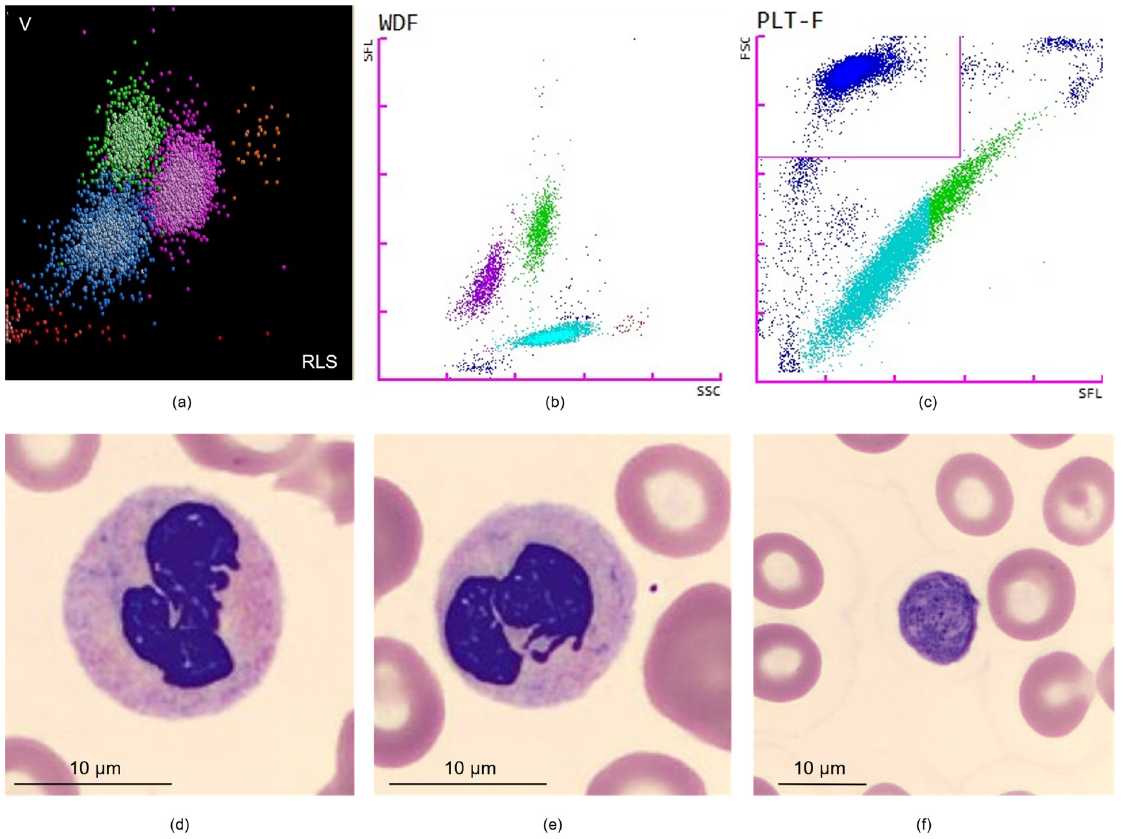
Figure 4. Illustration of typical MDS cases on DxH 800 and Sysmex-XN. ( a ) Leukocyte differential plot from DxH 800, showing decreased light scattering in a patient with myelodysplastic syndrome with excess blasts (MDS-EB-1). LMALS-NE-M, UMALS-NE-M and MALS-NE-M were decreased (128, 127 and 131, respectively). ( b ) Leukocyte differential plot from Sysmex-XN showing an increased Ne-WX (427) in this patient with normal neutrophil count (3.1 × 10 9 /L). This patient had normocytic anemia (Hb 9.7 g/dL, MCV 90 fL) and thrombocytopenia (platelet count: 107 × 10 9 /L), the MDS-CBC score was highly suggestive of MDS (0.755). This patient was diagnosed with MDS with multilineage dysplasia. ( c ) Fluorescence platelet count scatterplot from Sysmex-XN showing increased IPF% (19%) in this patient with macroplatelets on blood smear. ( d – f ) Blood film from patient illustrated in ( b ) and ( c ) showing hypogranular neutrophils ( d , e , magnification ×100) and a macroplatelet ( f , magnification ×50).